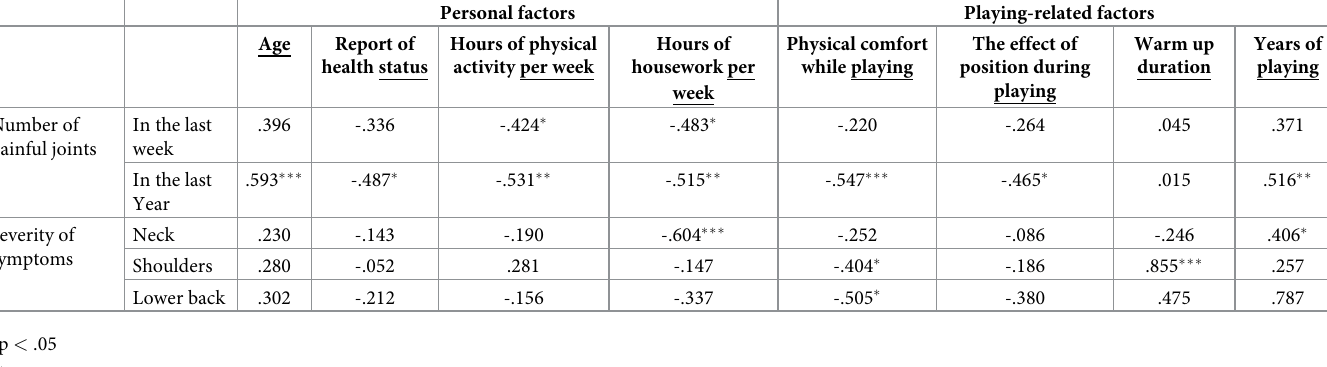
Table 1. Spearman’s rank correlations demographic characteristics, anthropometric measurements, playing habits, and personal habits of guitar player and their complaints of musculoskeletal pain.